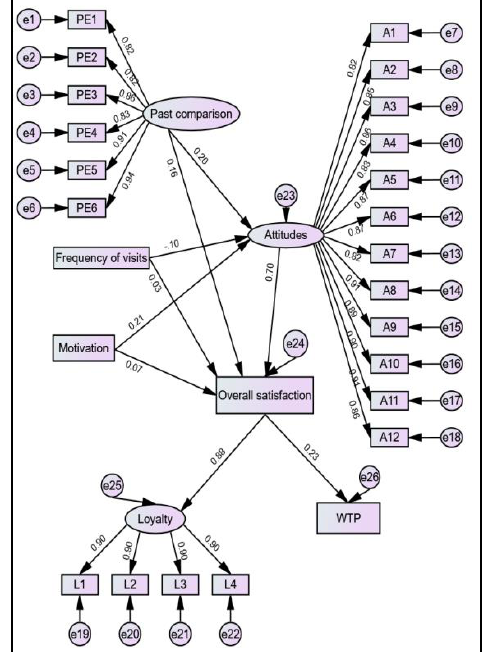
Figure 8. SEM for locals.